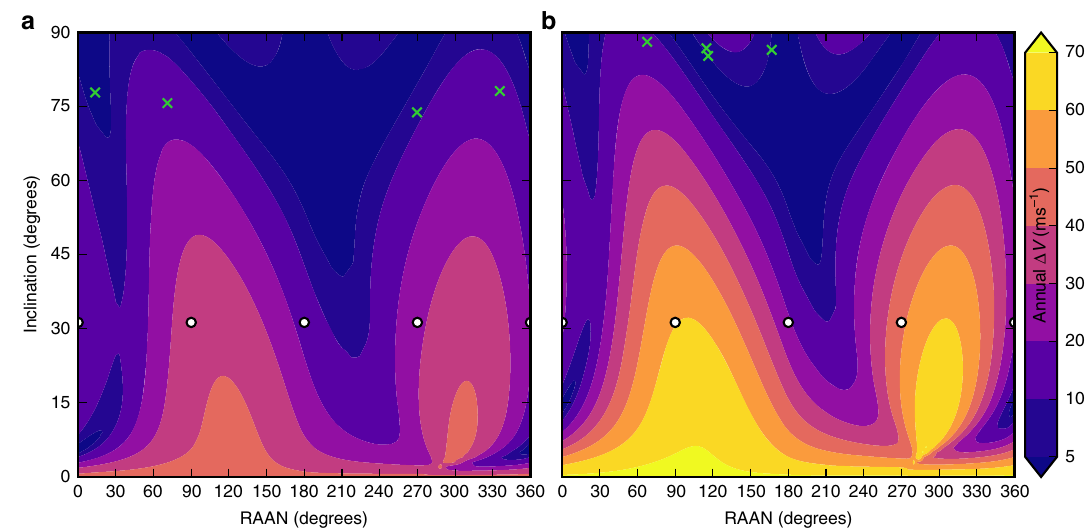
Fig. 4 Annual station-keeping Δ V required to maintain inclination. Varies according to inclination and right ascension averaged over 10 years. a Contours for 24-h orbits. b Contours for 48-h orbits. The green crosses on each plot indicate the position of the satellites in the constellations, and white circles indicate the location of satellites in a Draim